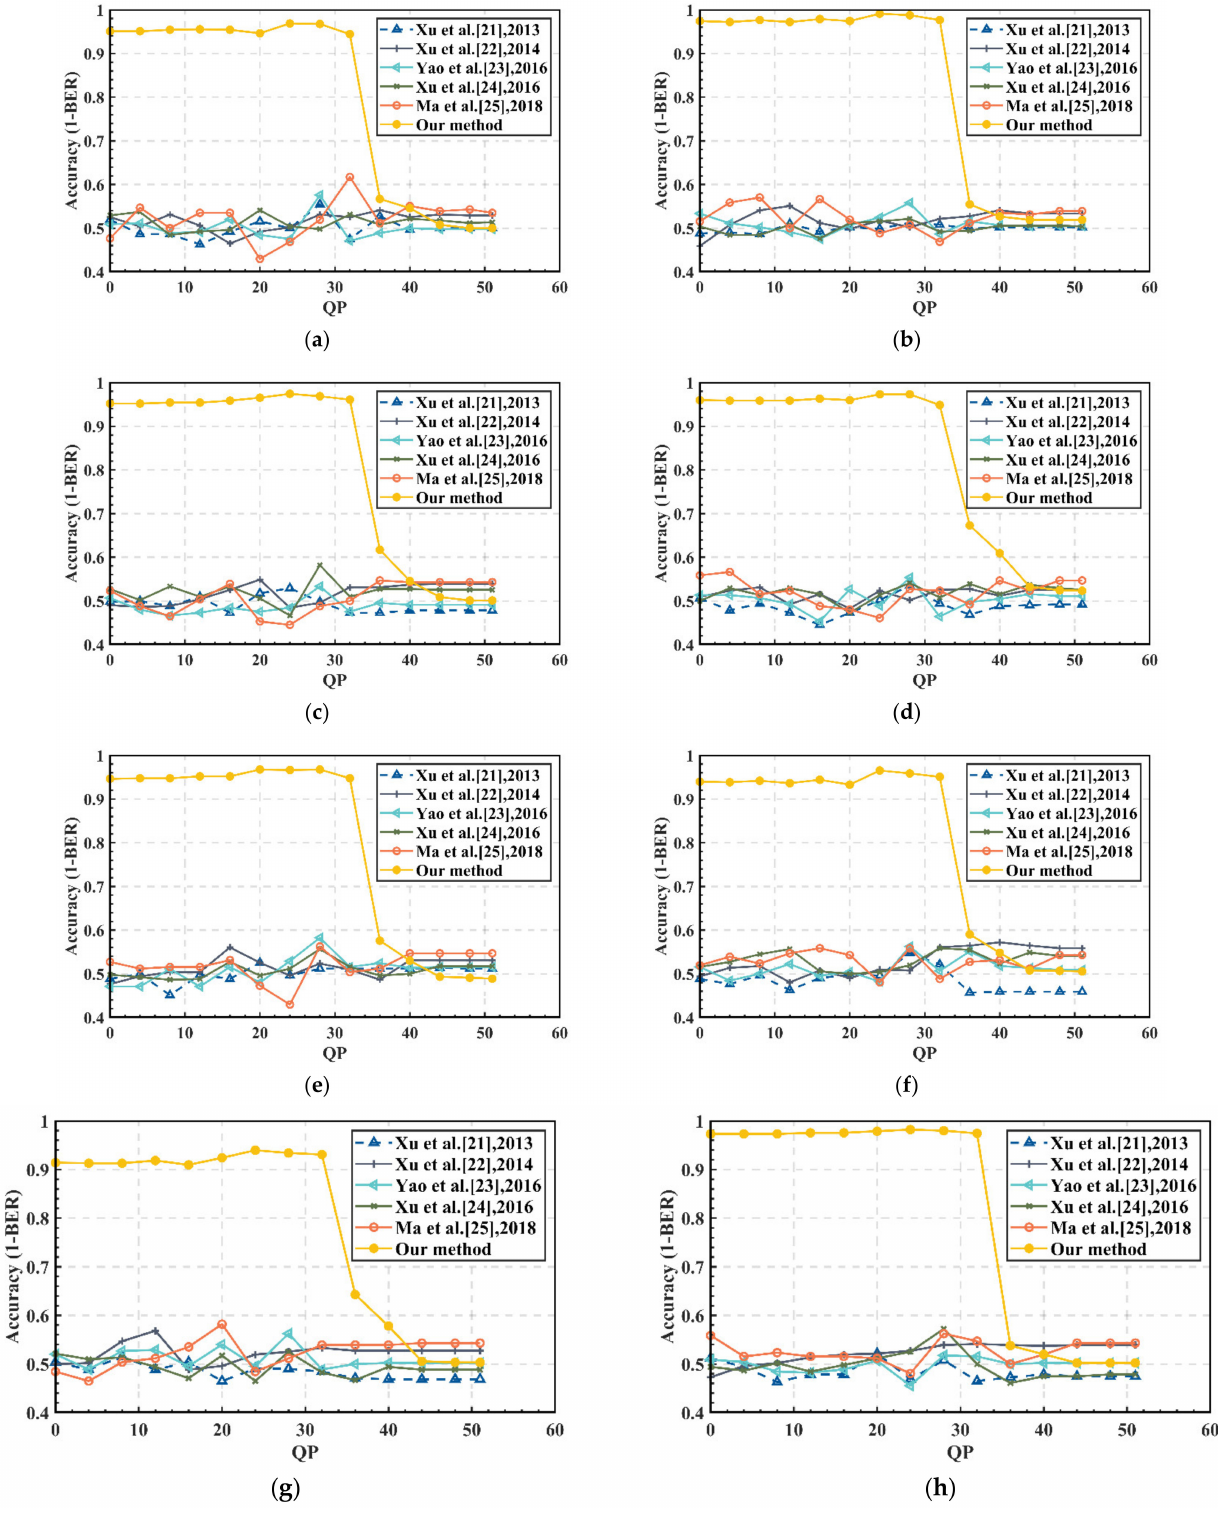
Figure 8. Extraction accuracy (1-BER) comparison between our method and the current methods [21–25] (original QP = 28). ( a ) container, ( b ) foreman, ( c ) salesman, ( d ) mobile, ( e ) carphone, ( f ) news, ( g ) city, ( h )